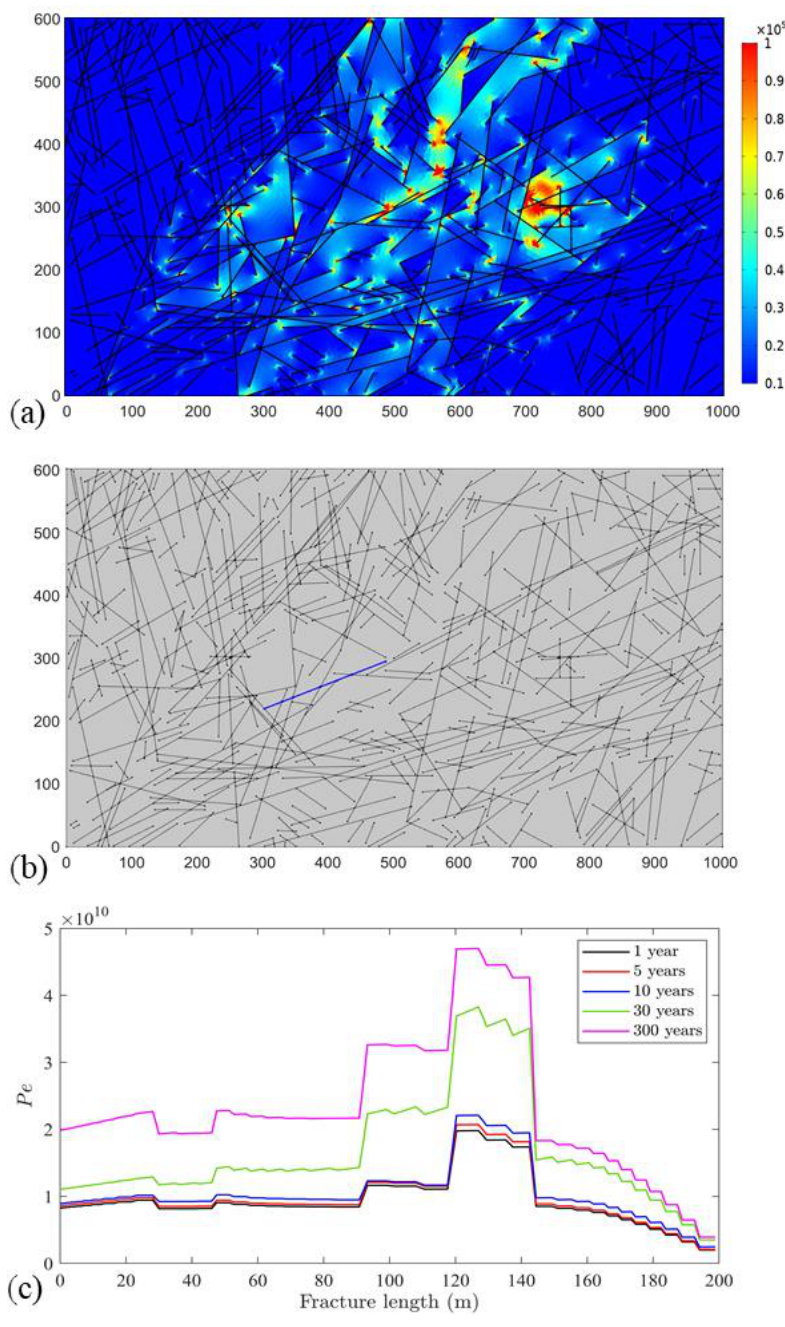
Figure 6. For case 180 and CO 2 as the working fluid after one year, ( a ) Peclet number distribution across the reservoir, ( b ) fracture considered for estimating fracture length, and ( c ) Peclet number along with the fracture length.